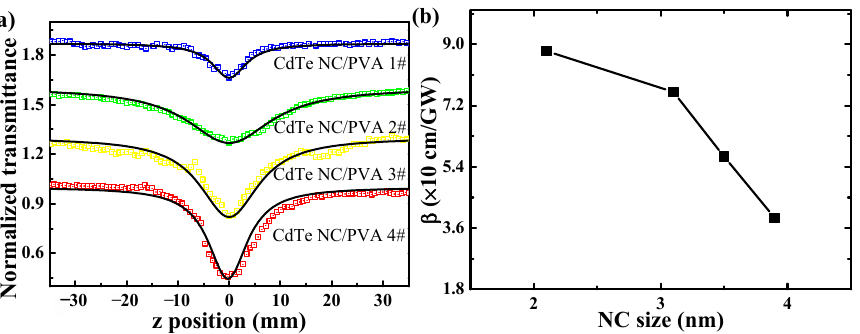
Figure 4. ( a ) Open-aperture Z-scan curves of a series of CdTe NC/PVA films; the black solid lines are the corresponding fitting curves. ( b ) TPA coefficient as a function of NC size in CdTe NC/PVA films.